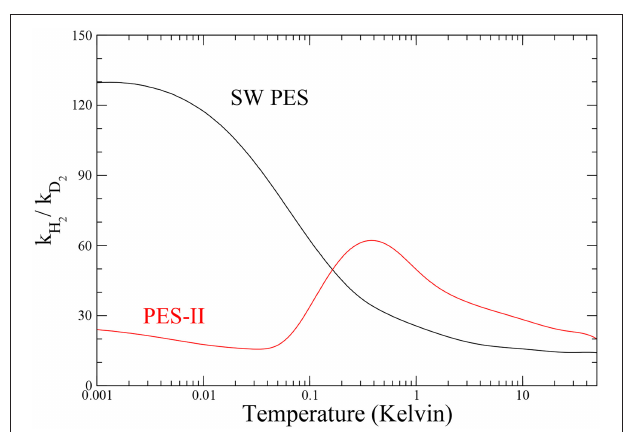
FIGURE 4 | Temperature dependence of the inter-molecular kinetic isotope effect for the two potential energy surfaces